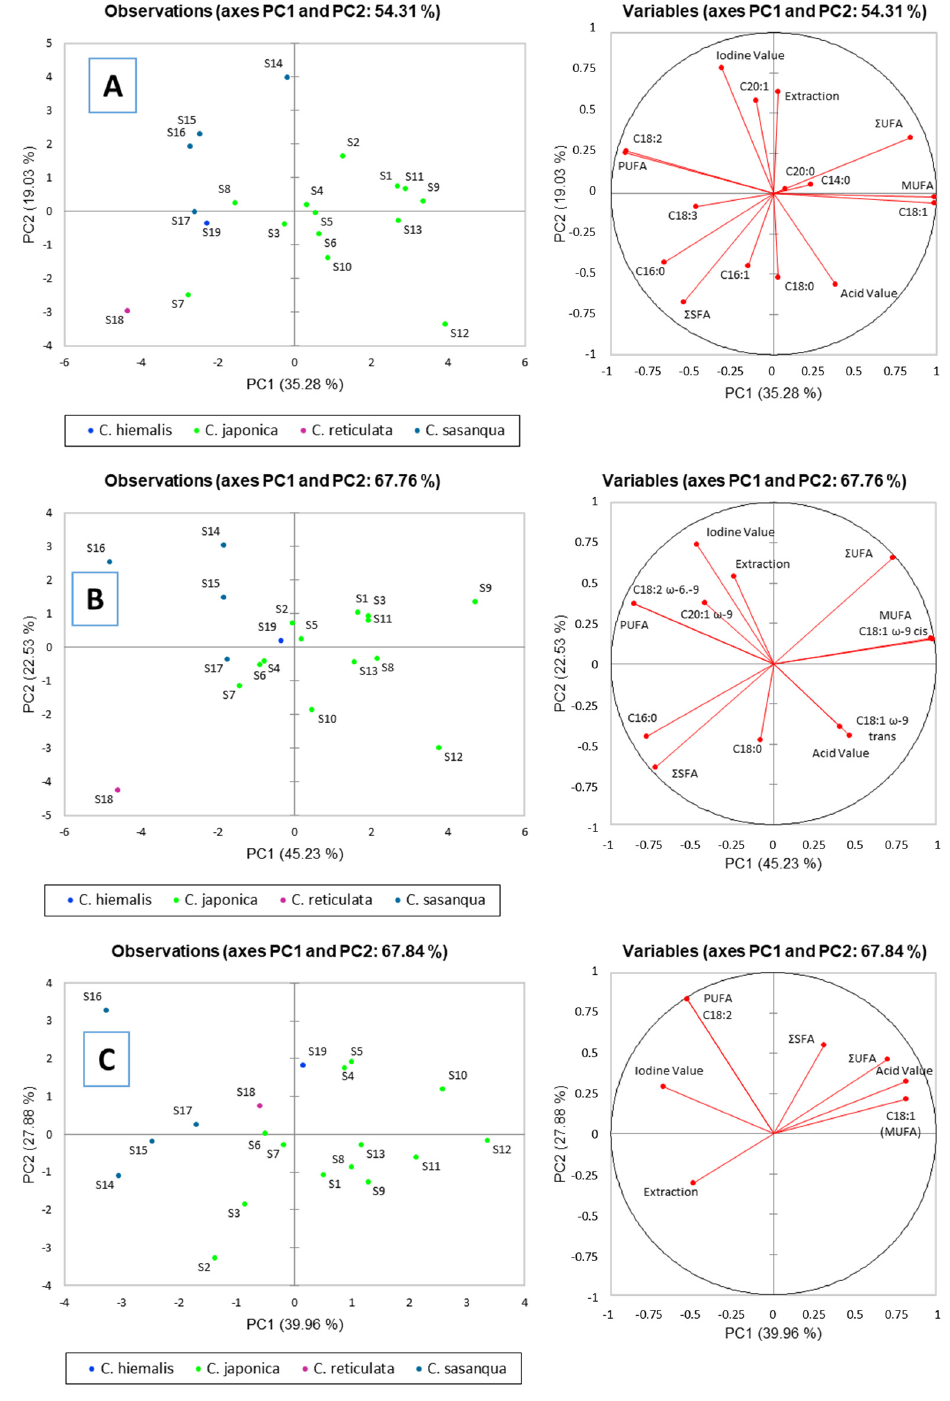
Figure 3. Principal component analysis plot of Camellia oils from different species. FAs were determined by ( A ) GC-FID, ( B ) GC-MS, ( C ) 1